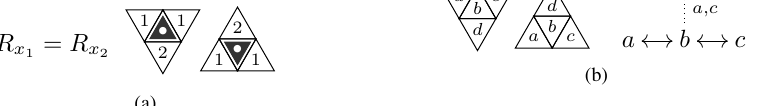
Figure 12: A forced game play of the (1